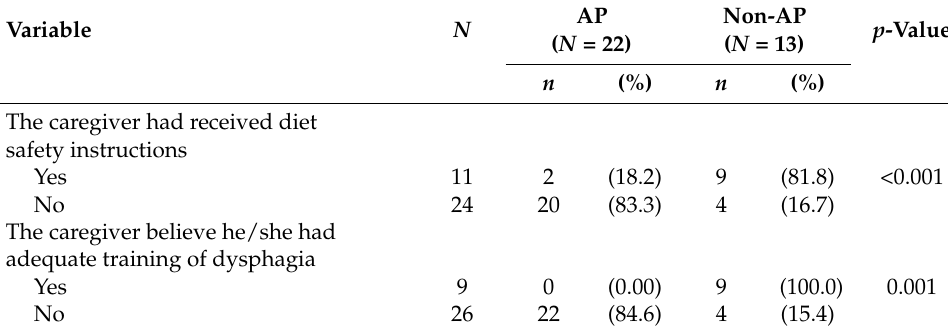
Table 5. Relationship between feeding instruction experience of caregiver and aspiration pneumonia of the participants of nasogastric feeding with combined oral